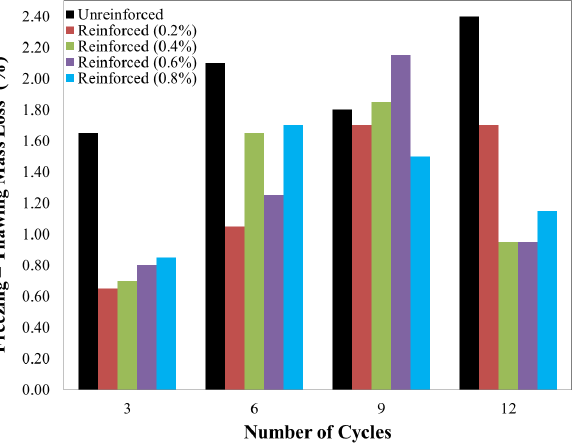
Figure 7 : Relationship between FTML and freezing–thawing